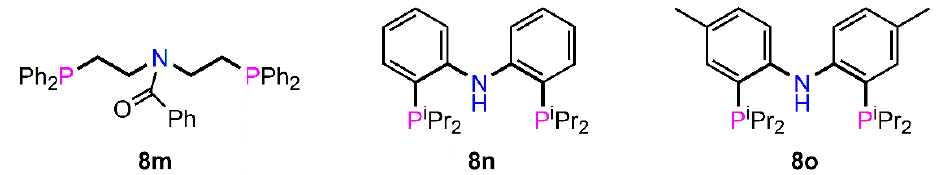
Figure 12. Selected examples of P–C–C–N–C–C–P diphosphines.